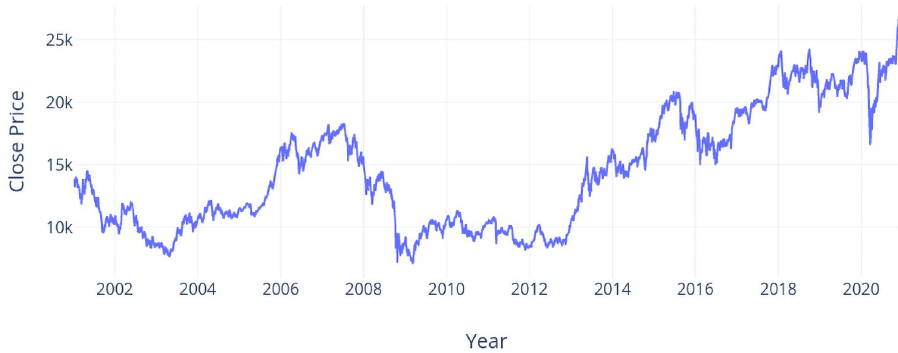
Fig 8. Close prices over years (NI225